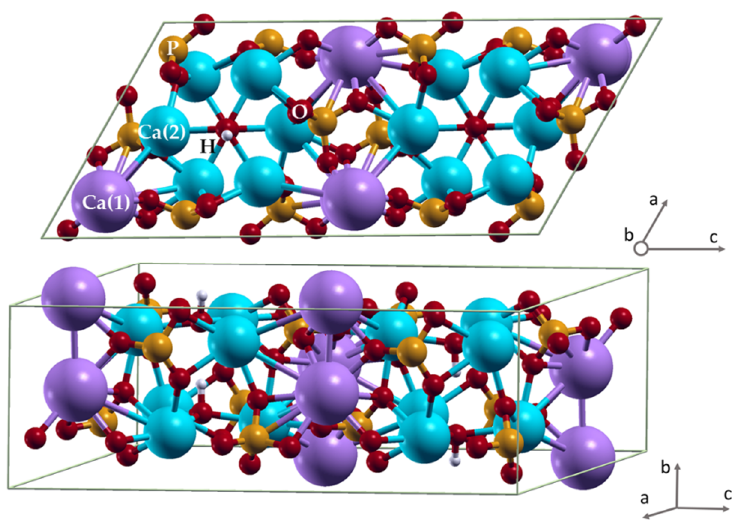
Figure 1. Hydroxyapatite unit cell. Color coding: phosphorus—orange, oxygen—red, hydrogen— light grey, Ca(1)—purple, Ca(2)—blue.